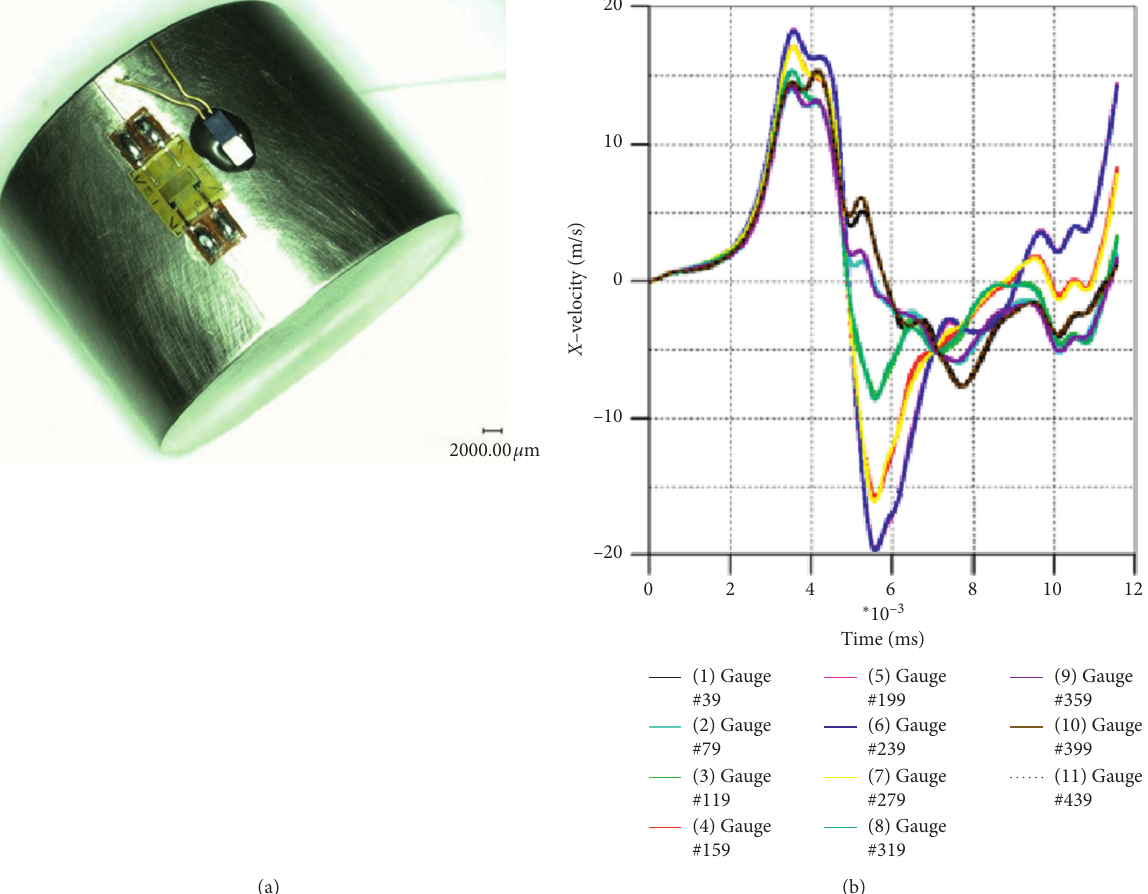
Figure 8: Inermet ® 180 specimen with Pt100 and bidirectional strain gauge (a); expected radial velocity on Inermet ® 180 sample, energy 440GeV, 3e12 protons (b)